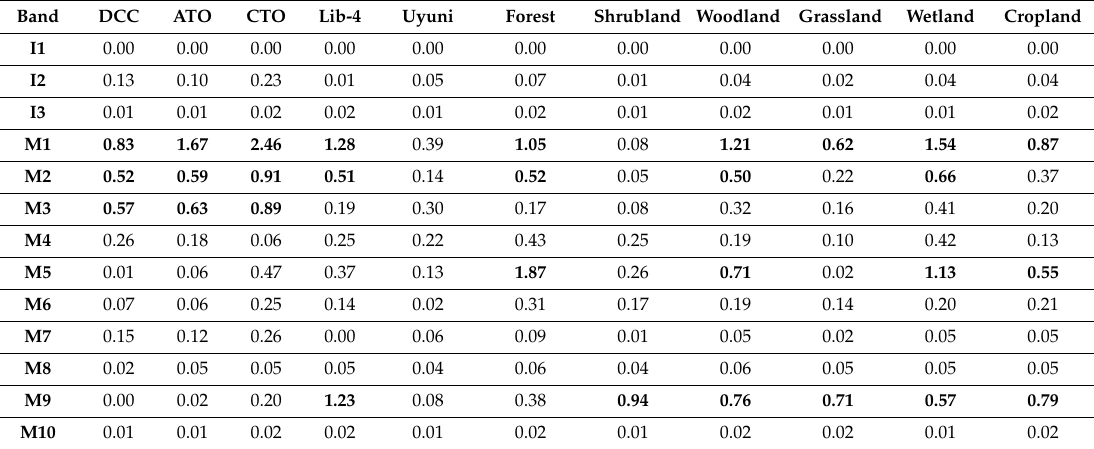
Table 3. S-NPP VIIRS GT RSR Earth-reflected scene-dependent radiance average OOB contribution ( γ ) for specified 1% extended bandpass limits, shown in %.